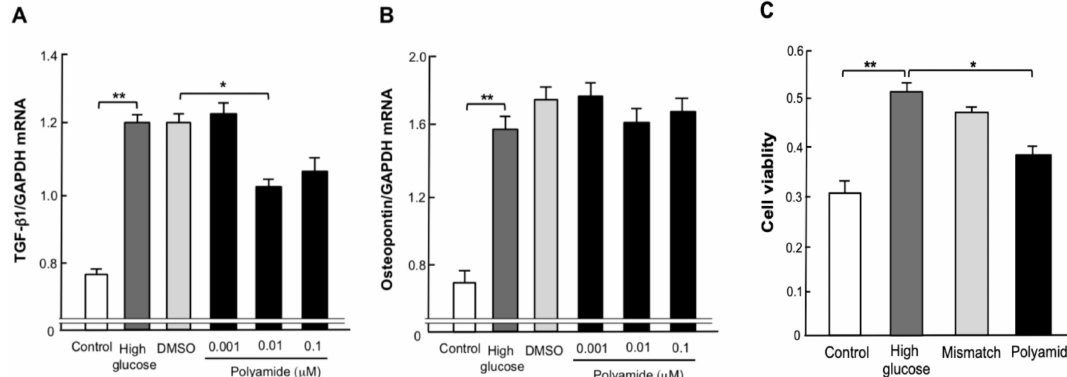
Figure 2. E ff ects of pyrrole-imidazole (PI) polyamide targeting TGF- β 1 on the expression of TGF- β 1 and osteopontin mRNAs, and growth of rat mesangial cells (MCs). Quiescent MCs from Wistar Kyoto rats were incubated with 25 mM glucose, 25 mM glucose plus 1 µ L / mL dimethyl sulfoxide (DMSO) and 25 mM glucose plus 0.01 to 0.1 µ M PI polyamide targeting TGF- β 1 for 6 h. Expression of ( A ) TGF- β 1 and ( B ) osteopontin mRNAs was evaluated by real-time polymerase chain reaction analysis. Relative gene expression was analyzed by the comparison to GAPDH mRNA. ( C ) MCs were stimulated with 10% FBS in high-glucose DMEM with 0.01 µ M PI polyamide targeting TGF- β 1 or Mismatch polyamide for 24 h. Growth of MCs was evaluated by WST-1 assay. Data are the mean ± SEM (n = 6). * p < 0.05, ** p < 0.01 between indicated